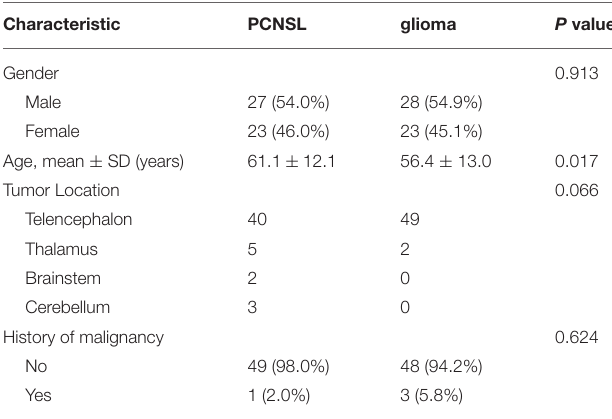
TABLE 1 | Demographic and clinical characteristics of all